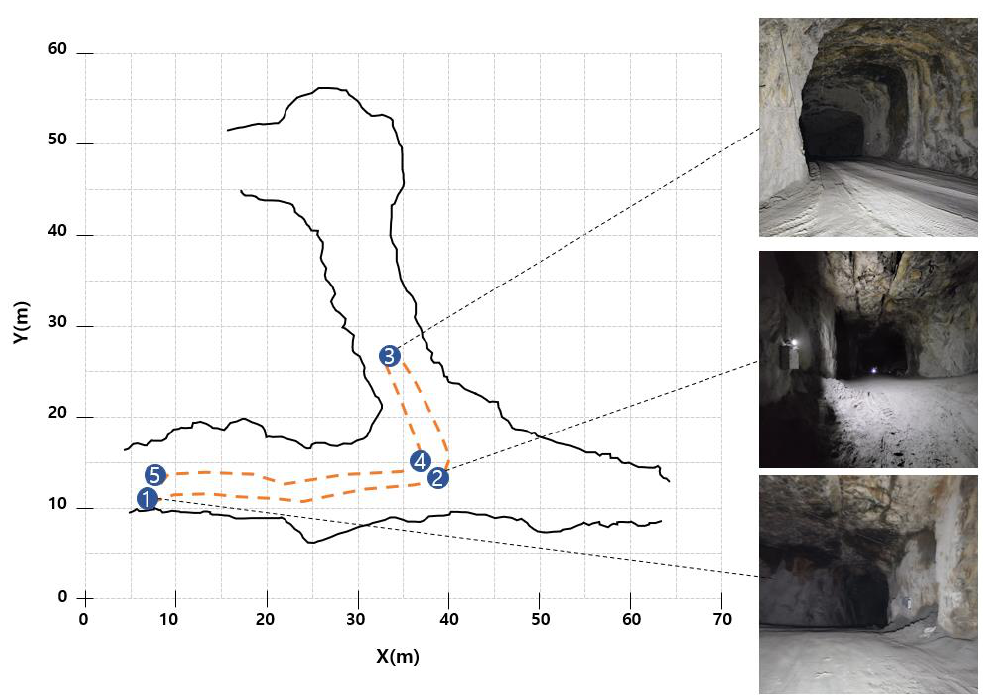
Figure 9. Conceptual diagram of the field experiment area in the underground mine. Circled numbers indicate the order of the robot’s moving points.